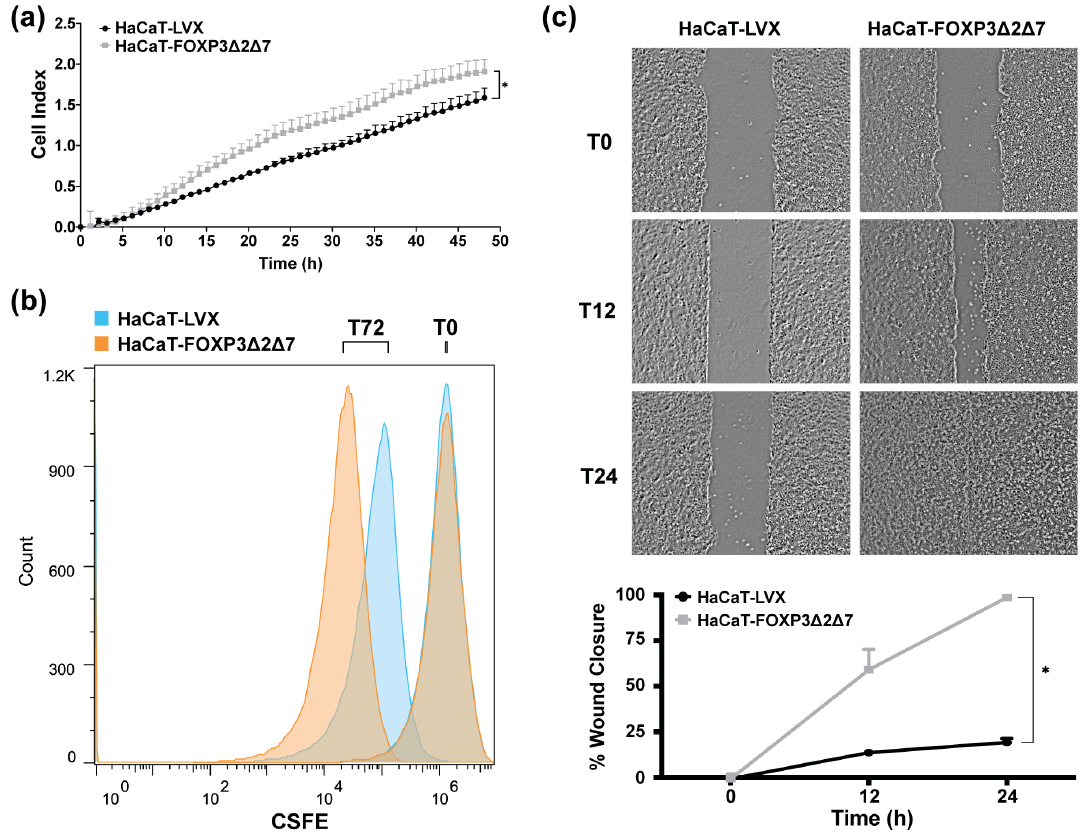
Figure 5. Evaluation of biological effects by FOXP3 ∆ 2 ∆ 7 exogenous expression in vitro. ( a ) Real-time cell proliferation analysis with xCELLigence RTCA platform for 48 h; values are expressed as cell index; ( b ) cell division tracking with CSFE reagent, fluorescence measurement was achieved with flow cytometry at the initial time point and 72 h later; ( c ) depictive images of wound healing assay and plot of wound closure percentage during 24 h; photographs were acquired at 4× amplification and processed with ImageJ software. (*) depicts statistical significance with a p -value < 0.05.